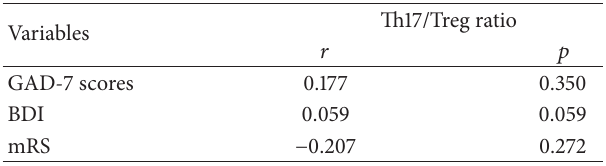
Table 2: Anxiety, depression, and sleep disturbance in the PSF patients.